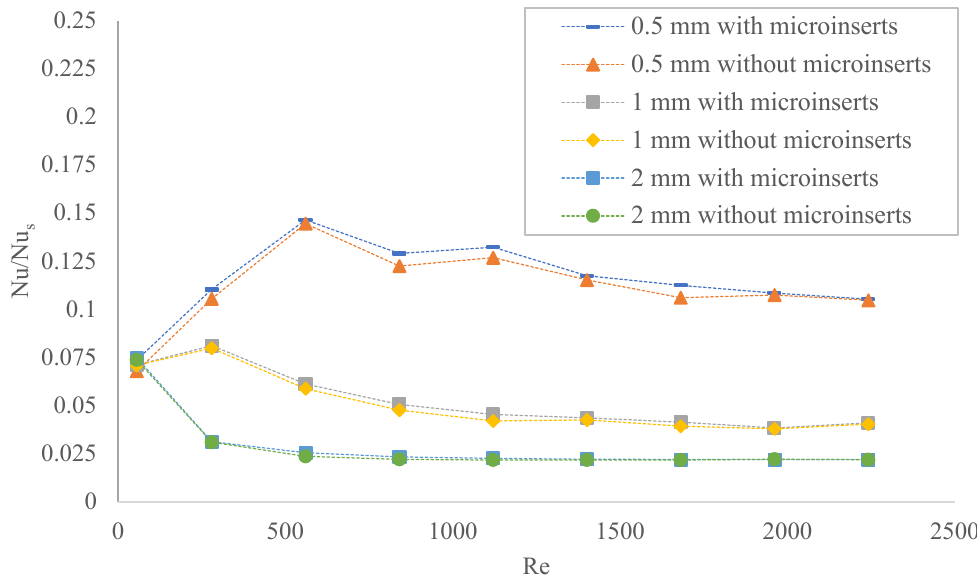
Figure 10. Variation of Nu/Nu s with Reynolds number.